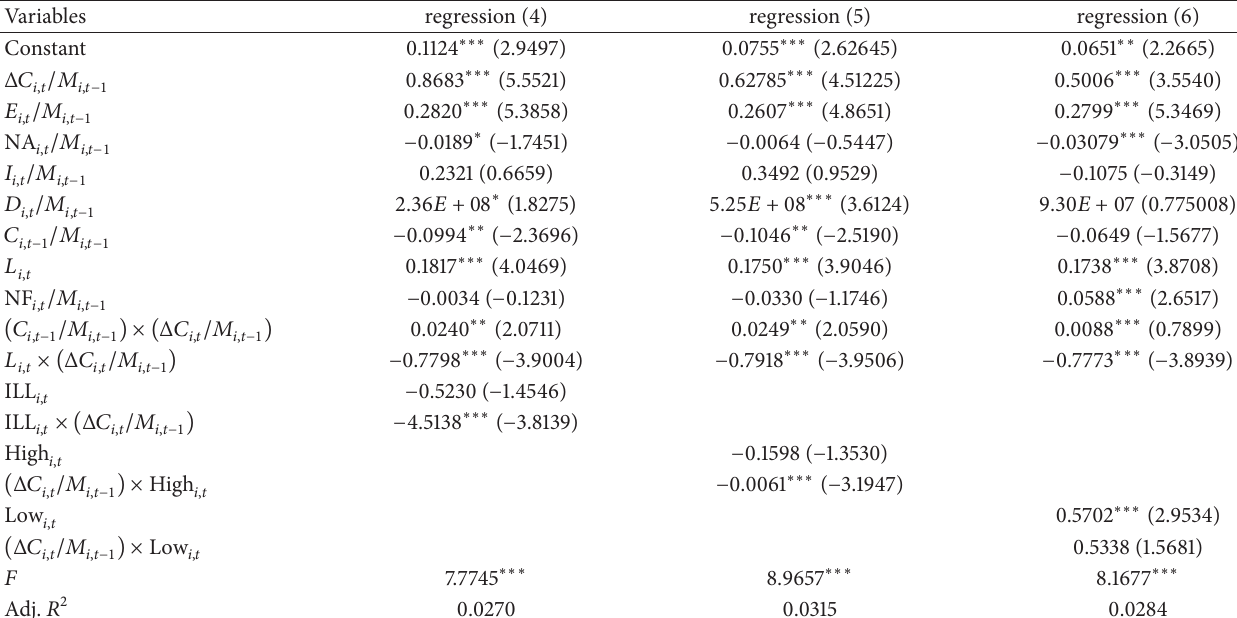
Table 7: Test result of